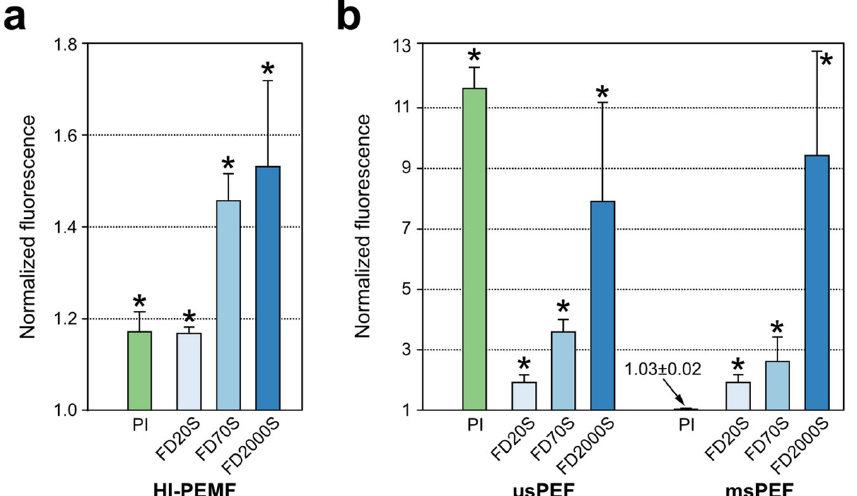
Figure 4. Fluorescence of PI and dextrans for HI-PEMF ( a ) and both PEF pulses ( b ) normalized to corresponding controls—note different ranges in ( a , b ) plots. Asterisk (*) denotes statistical difference between treated sample and its corresponding untreated sample ( p < 0.05). Mean ± standard deviation is shown for each treatment.